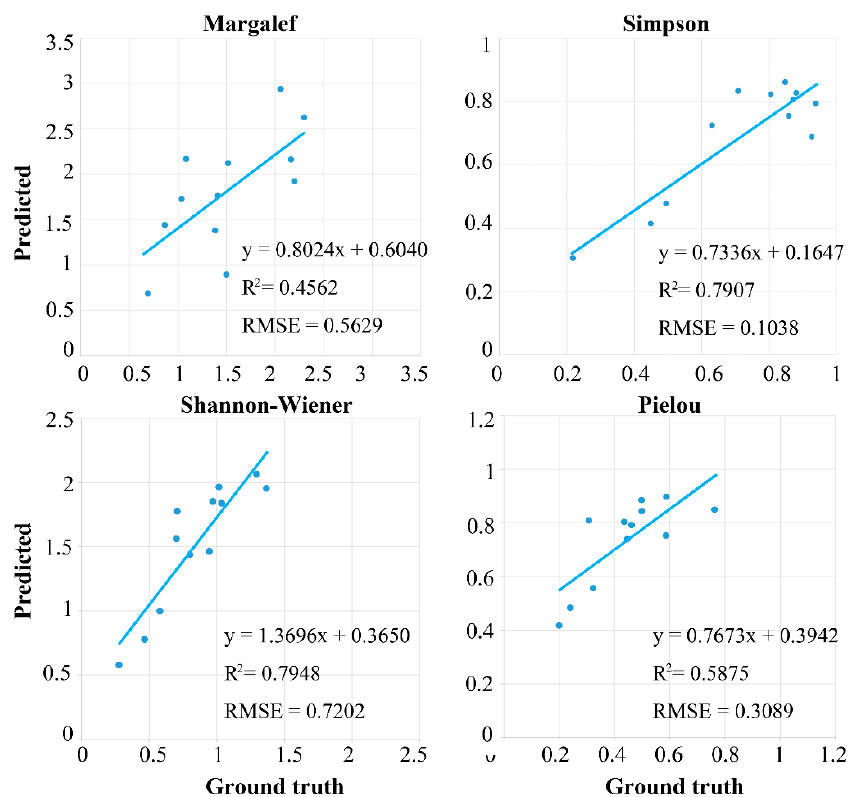
Figure 6. Field survey diversity index compared with the VGG16 predicted value.